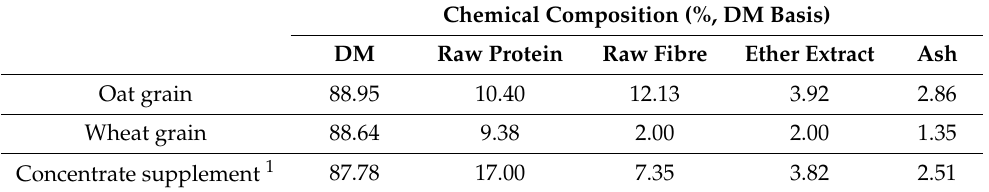
Table 1. Main supplementary feeds during fattening period and their chemical composition in Mallorquina and Roja Mallorquina